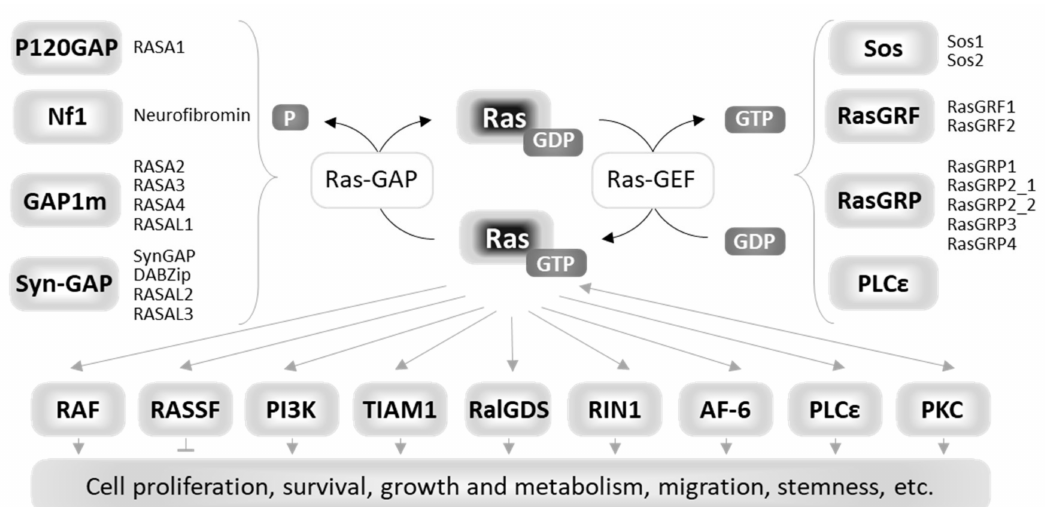
Figure 1. Diagrammatic representation of the functional cycle, upstream regulators, and downstream e ff ectors of Ras